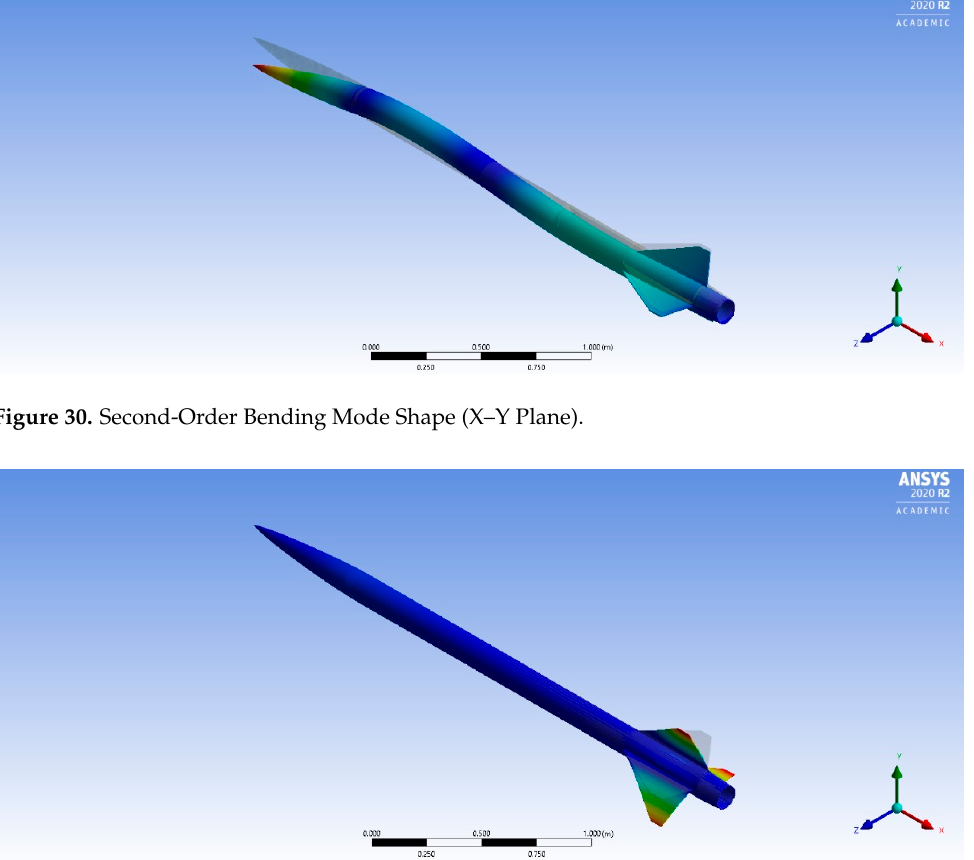
Figure 29. Second-Order Bending Mode Shape (X–Z Plane).